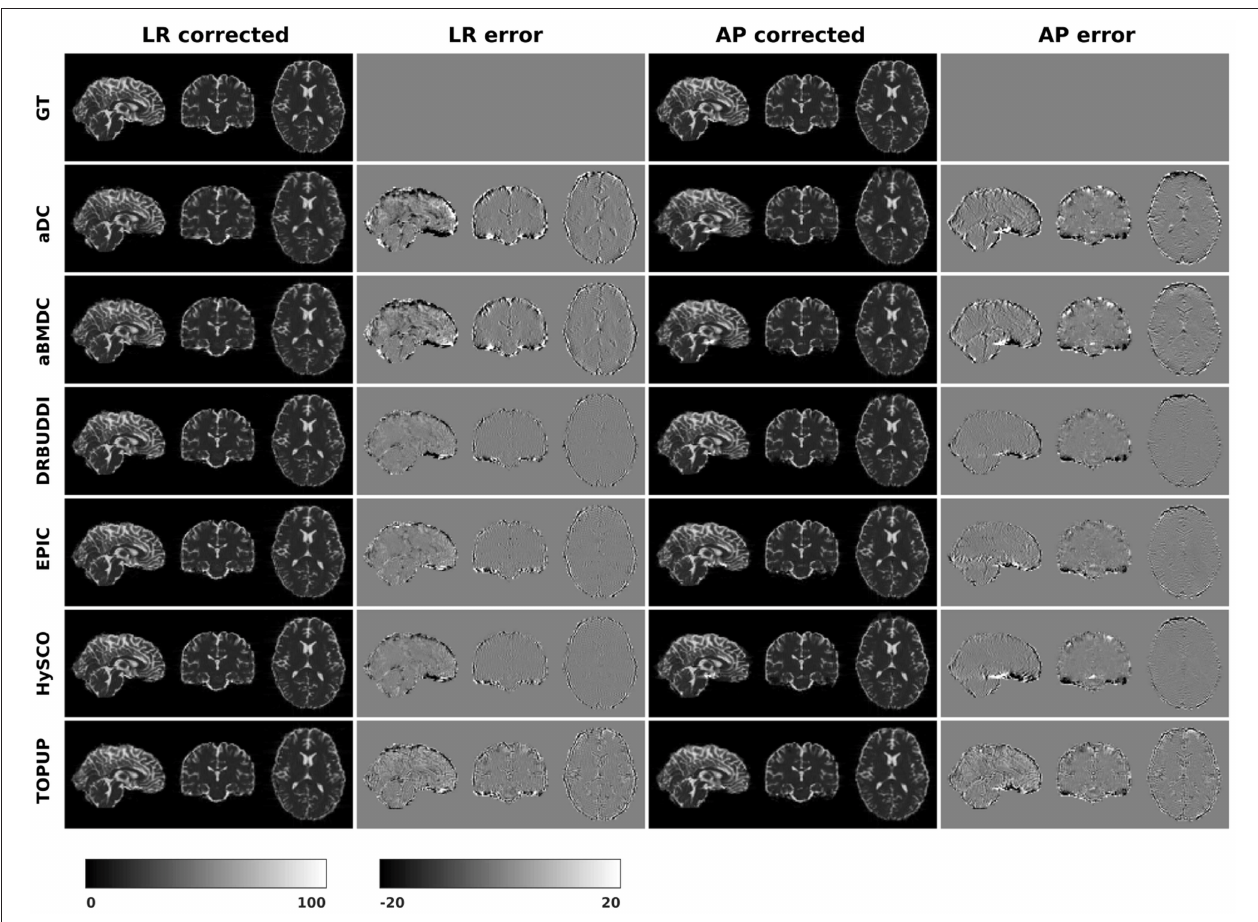
FIGURE 3 | Corrected b 0 volumes for simulated HCP Subject 100206 using the six methods. Error maps were obtained by calculating the difference compared to the ground truth. Correction was carried out for LRRL and APPA pairs, respectively.